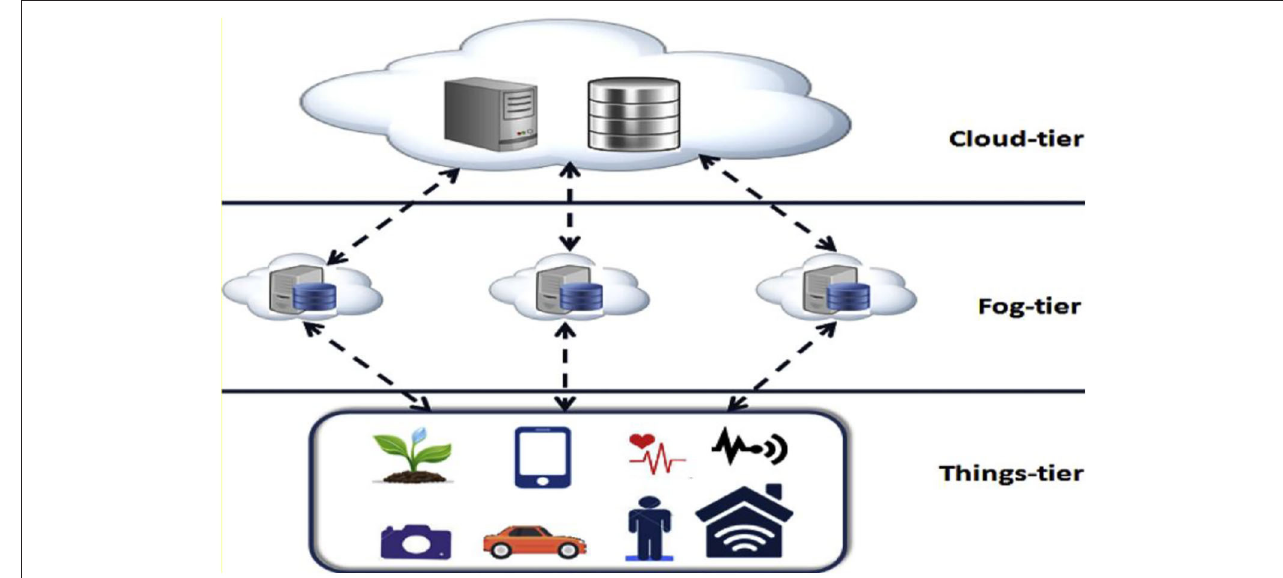
FIGURE 1 | The Fog-enabled Cloud IoT